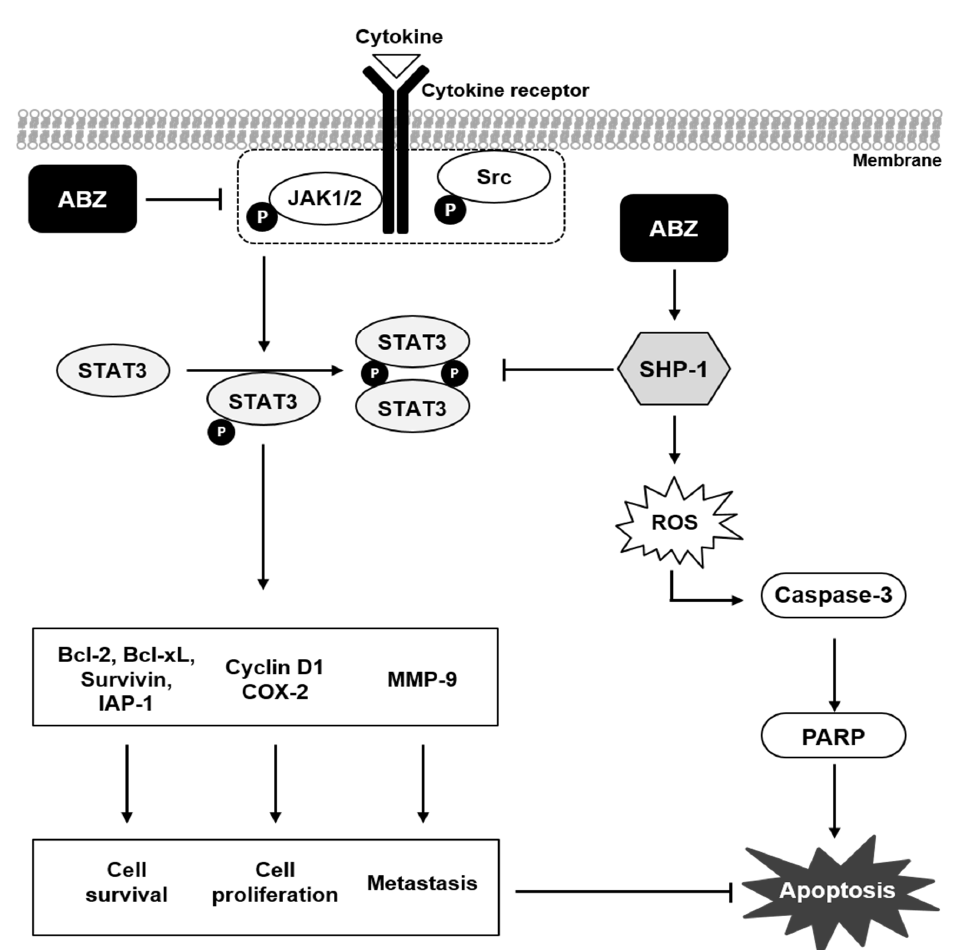
Figure 7. A schematic diagram showing the effects of ABZ on STAT3/5 signaling pathway via modulating SHP-1 expres- sion.